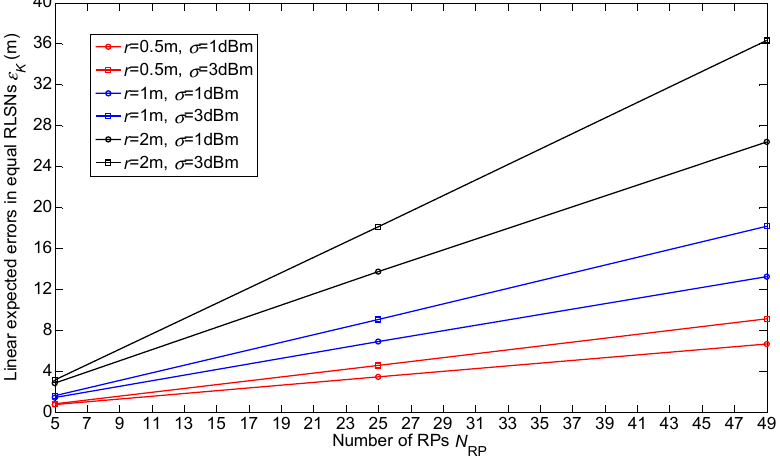
Figure 8. Linear expected errors with variations of r and σ in equal-weighted RLSNs ( K = 3).